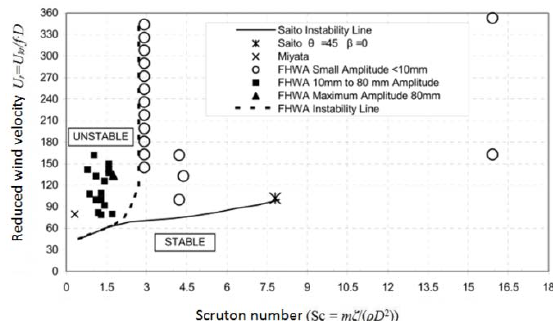
Fig. 9 . Dependence between wind velocity and Scruton number